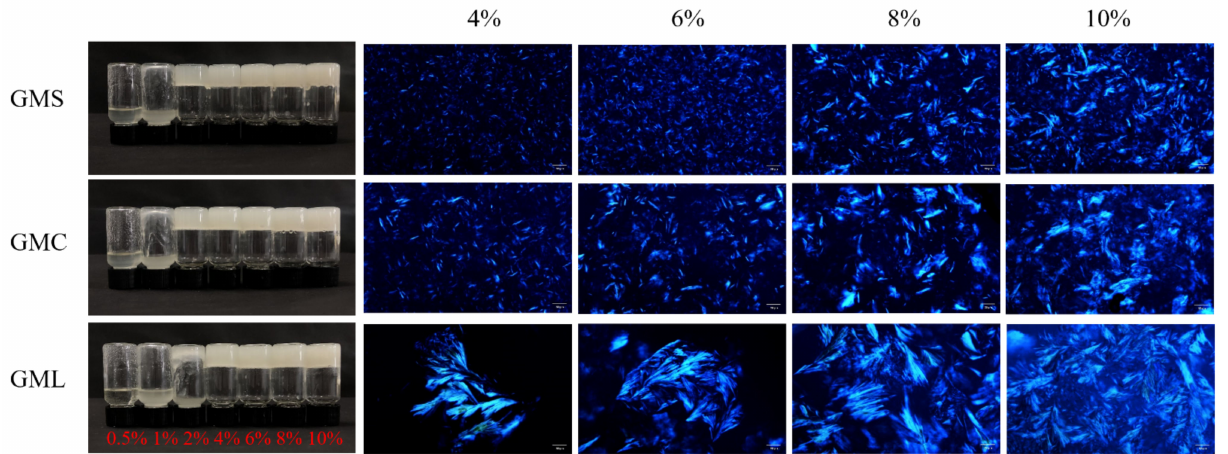
Figure 1. Visual appearance and polarized light microscopy images of different monoglyceride oleogels with different concentrations. The scale bar is 50 µ